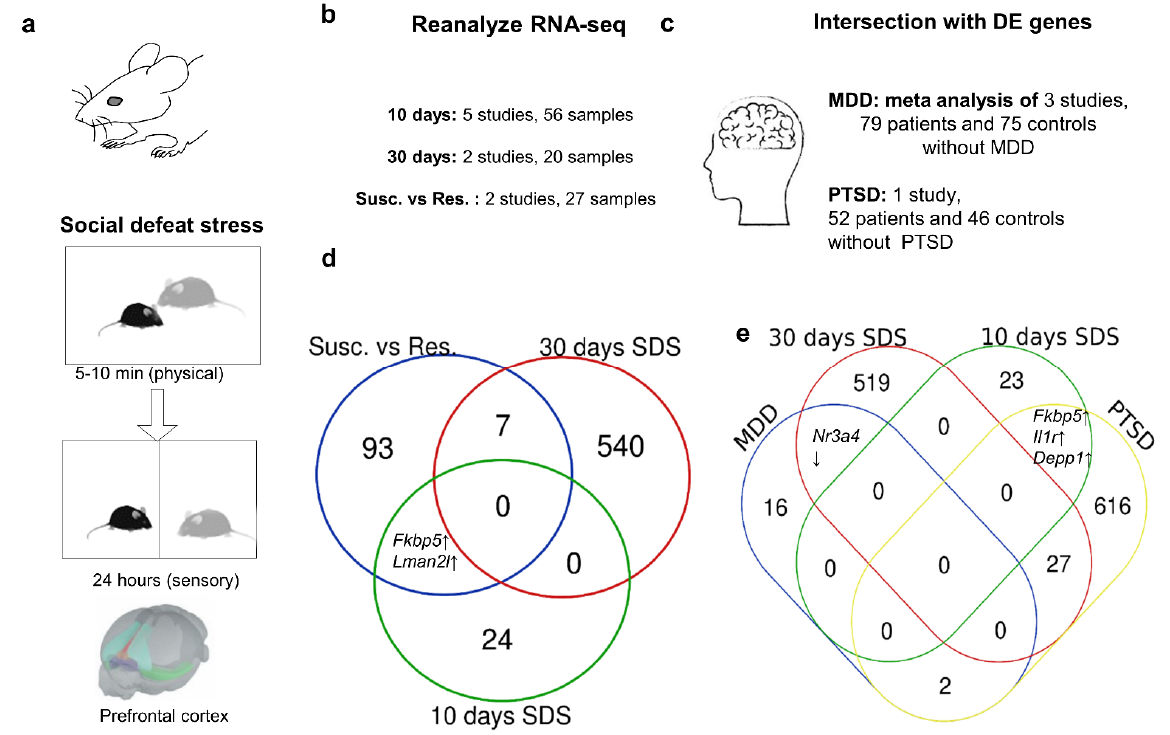
Figure 4. Experimental design. ( a ) Brief overview of the SDS paradigm. ( b ) Datasets of RNA-seq data on the PFC from SDS-exposed mice that were used for reanalysis. ( c ) Datasets of RNA-seq data on dorsolateral PFC (BA09) from postmortem samples from PTSD patients (52 PTSD: 26 males, 26 females; 46 control: 26 males, 20 females; age range > 18 to <70 years) and MDD patients (79 MDD: 49 males, 30 females; 75 controls: 57 males, 18 females; age range > 19 to <82 years) that were used for comparisons with SDS datasets. ( d ) A Venn diagram of DEGs (padj < 0.05) across different SDS datasets. ( e ) Comparisons of DEGs from the murine SDS data sets and from PTSD and MDD datasets of humans. Susc.: susceptible mice; Res.: resilient mice.